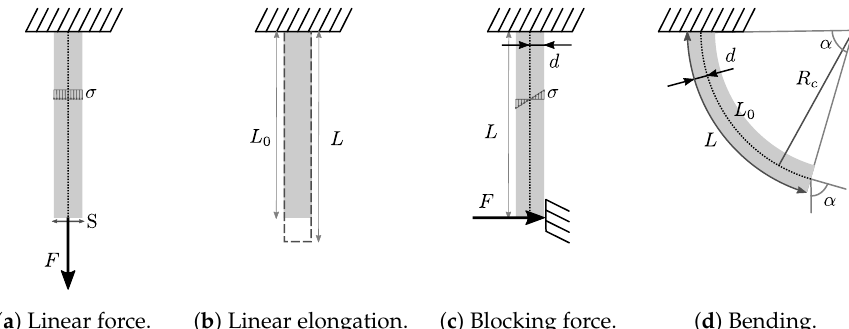
Figure 4. Stress and strain for linear elongation and bending: the dashed lines are the neutral